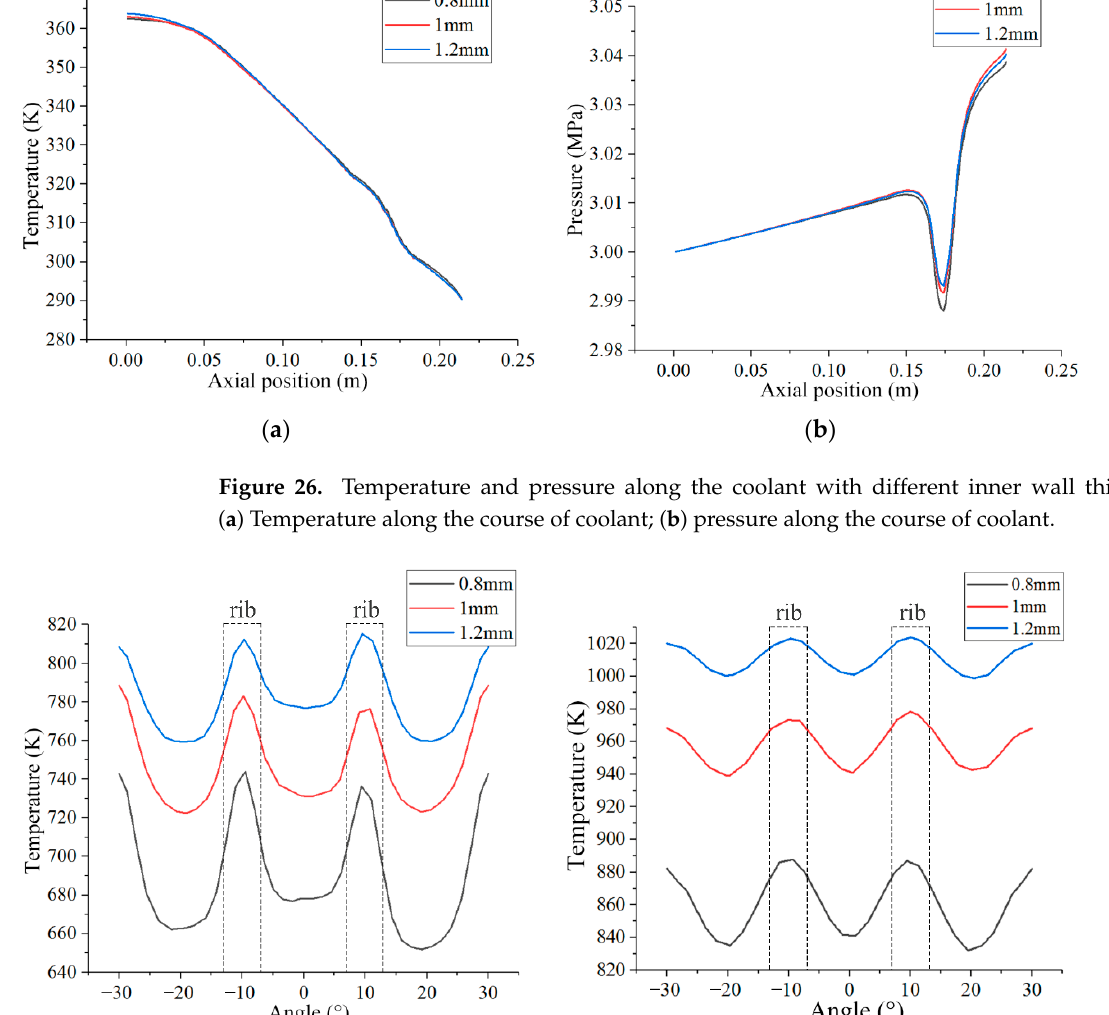
Figure 26. Temperature and pressure along the coolant with different inner wall thicknesses. ( a ) Temperature along the course of coolant; ( b ) pressure along the course of coolant.